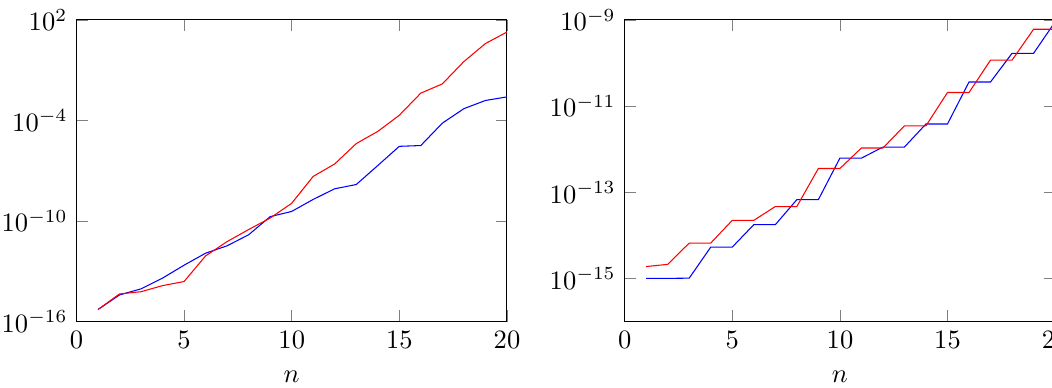
Figure 4: Biorthogonality and projection error, respectively left and right, for a normal matrix A ∈ C 200×200 , with condition number κ ( A ) = 10 . Two-term recurrence relation in blue and four-term recurrence relation in red.